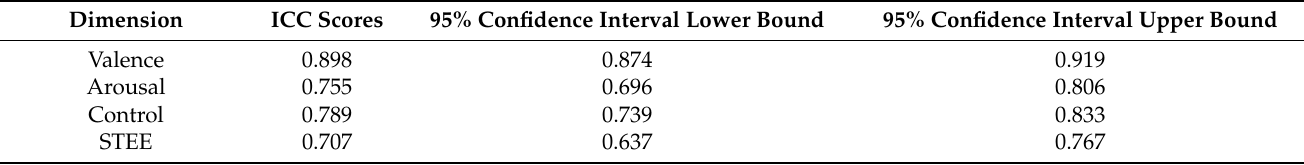
Table 3. Results of the ICC scores.